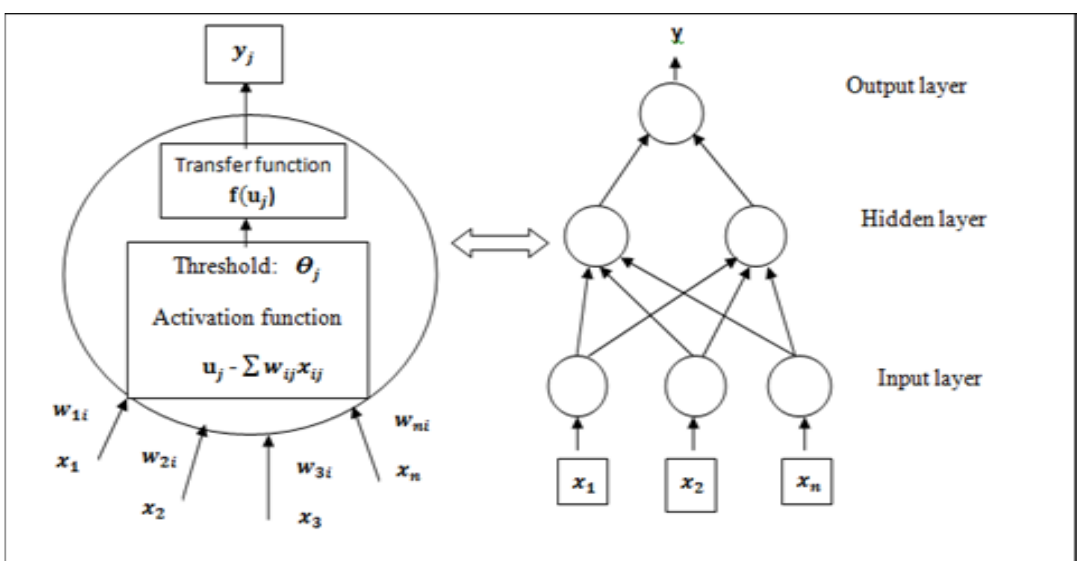
Figure two: The Back Propagation Algorithm